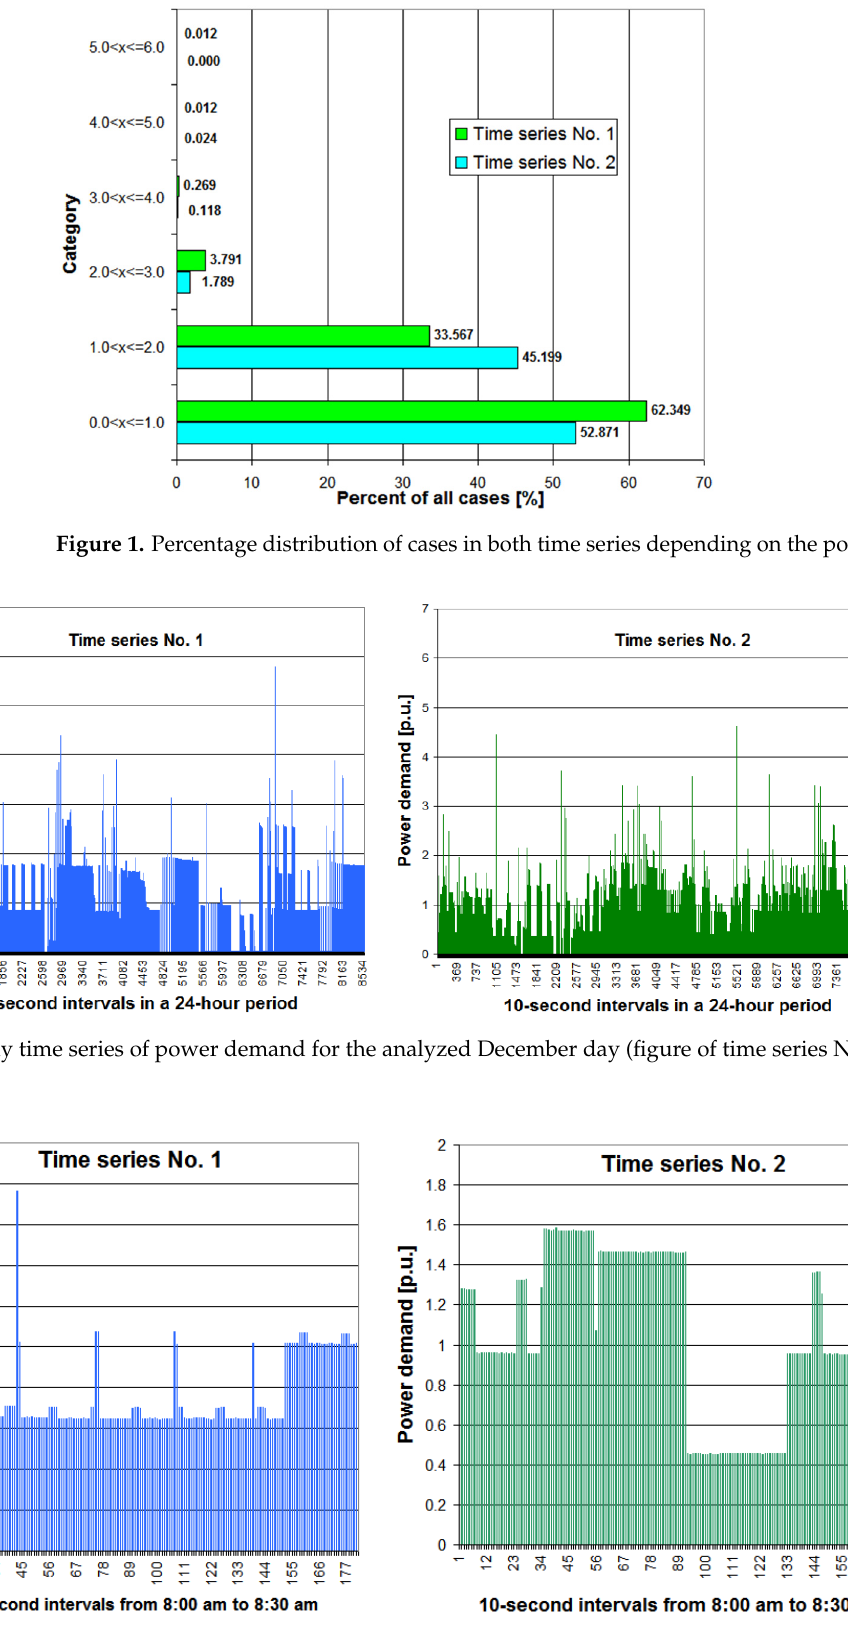
Figure 3. Two selected 30 min periods of power demand in the considered December day.